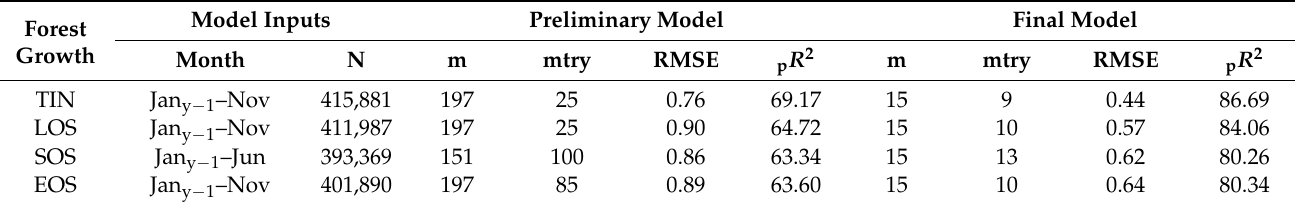
Table 3. Inputs and outputs from preliminary and final RF (Random Forest) models. Model Inputs are the independent variables considered in each model and the time period considered ( y − 1 = lagged). N is the number of observations (pixels) used to train each model and was identical for the preliminary and final models. m is the number of independent variables used in each model. mtry is the number of randomly selected variables tested for best split at each node. RMSE is root-mean-squared error calculated using the validation dataset. p R 2 (pseudo- R 2 ) represents the percent of variance explained by the model. Forest growth indices: TIN = Time-integrated NDVI; LOS = length of growing season; SOS = start of season date; EOS = end of season